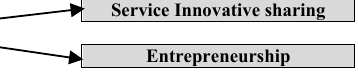
Fig. 1. The proposed